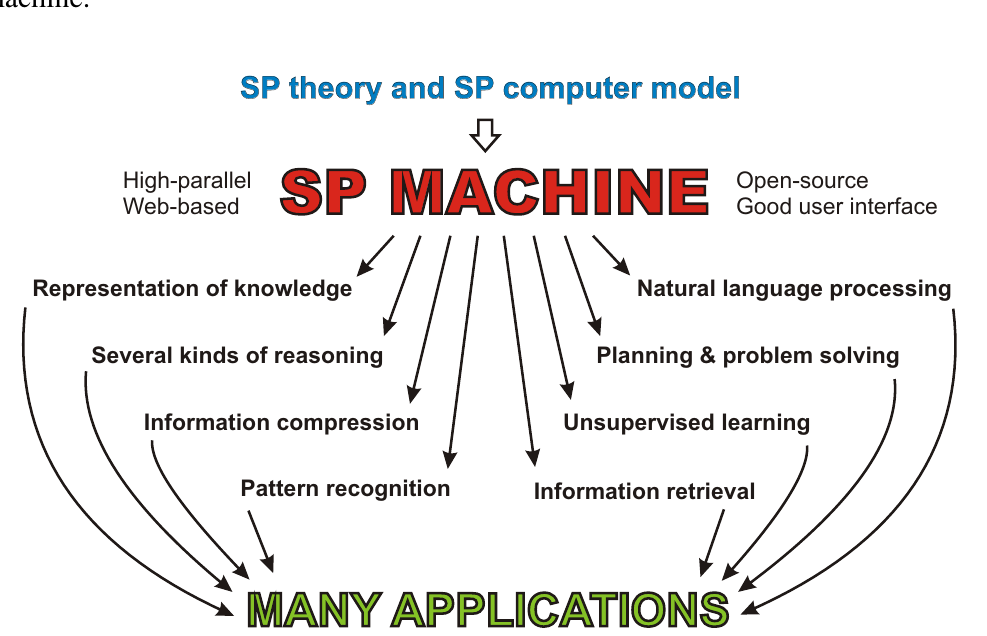
Figure 2. Schematic representation of the development and application of the proposed SP